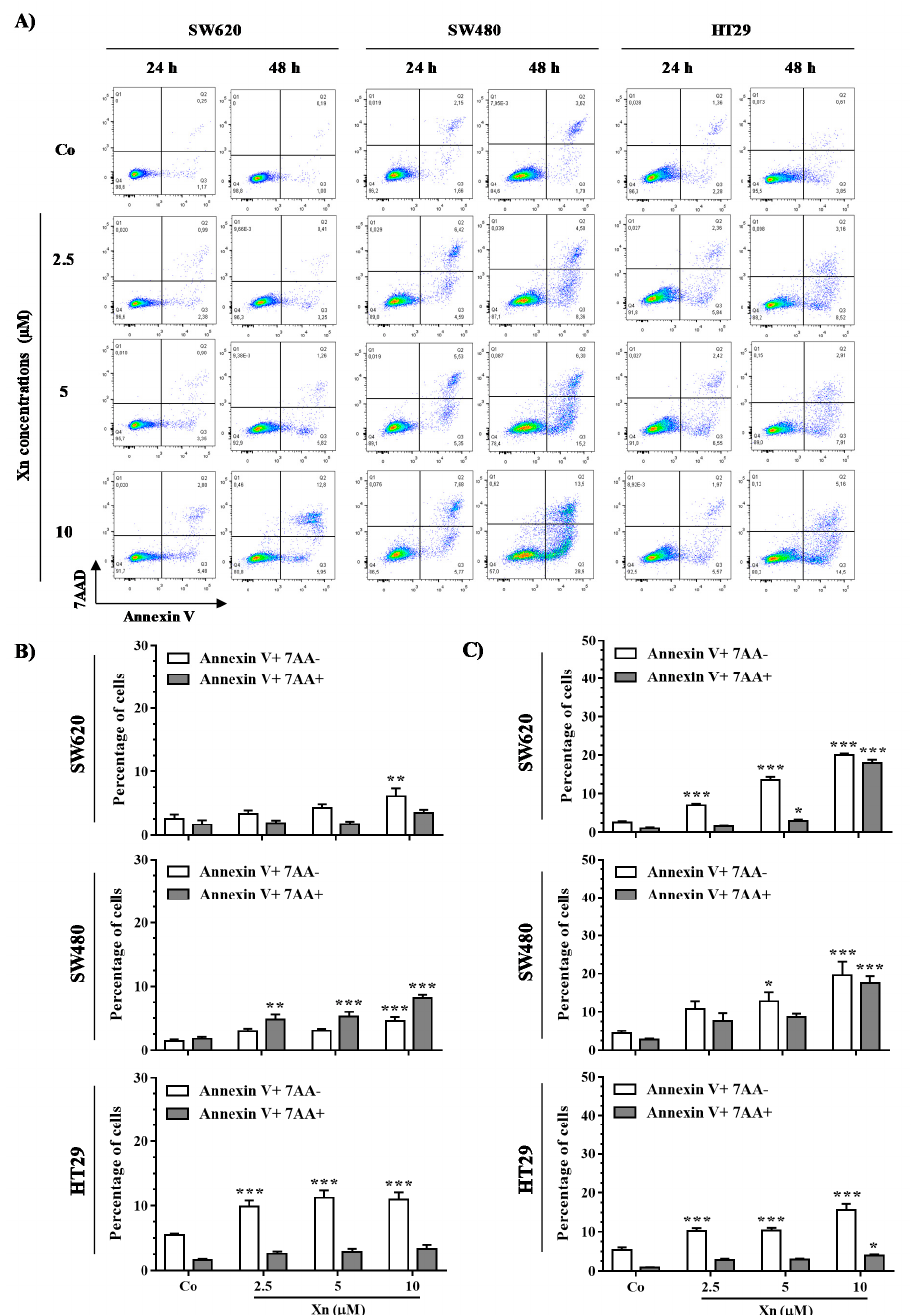
Figure 7. Xanthohumol (Xn) induces apoptosis of colon cancer cells. After 24 h of culture, colon cancer cells SW620, SW480, and HT29 were treated with medium containing vehicle control (0.1% DMSO; Co) or increasing concentrations of Xn (2.5, 5, and 10 µM) for 24 and 48 h and then stained with Annexin V / 7-aminoactinomycin D (7AAD) at the end of treatment. ( A ) Representative Annexin V / 7AAD flow cytometry dot plots, obtained from colorectal cancer cells treated with the indicated Xn concentrations for 24 and 48 h. The percentages of early apoptotic cells (identified as the Annexin V-positive / 7AAD-negative population, in white bar) and late apoptotic cells (identified as the Annexin V-positive / 7AAD-positive population, grey bar) were calculated, after 24 h ( B ) and 48 h ( C ) of treatment with the indicated Xn concentrations. The data are means ± SEM of three independent experiments. p values were determined by a two-way ANOVA followed by Tukey’s multiple comparison test. * p < 0.05, ** p < 0.01, and *** p <